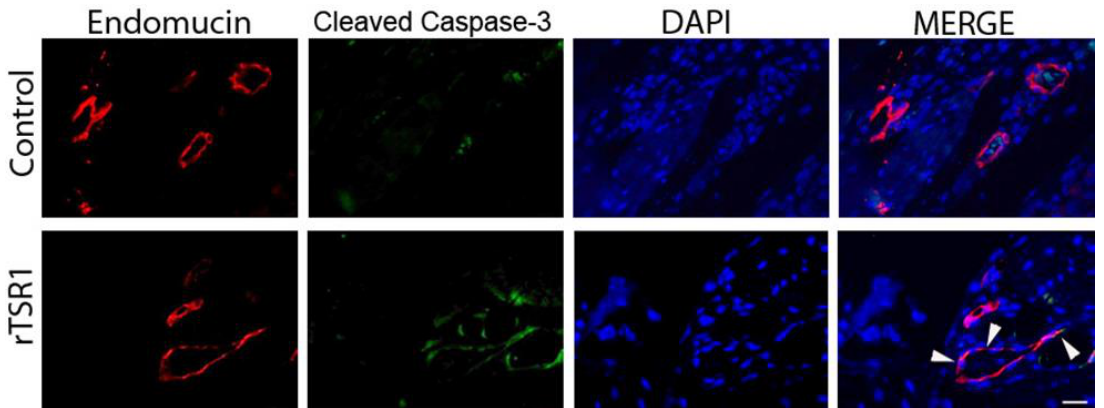
Figure 5. The rTSR1 induced apoptosis in tumor endothelial cells. Representative microscopic images show the increased apoptotic endothelial cells in an rTSR1-treated tumor compared to the control. Red indicates the endothelial cells (endomucin-positive) and green indicates the cleaved caspase-3-positive cells. DAPI was used as the nuclear counter stain. The arrow heads indicates the cleaved caspase-3-positive endothelial cells. Scale bar: 20 μm.